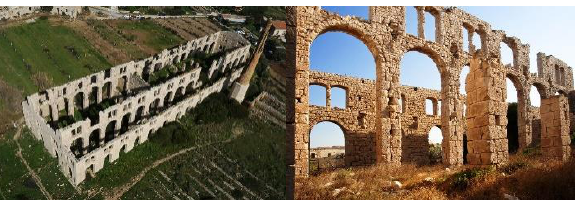
Figure 3. Fornace Penna in Scicli: view from an UAV image acquired for the test (left) and inaccessible inner space